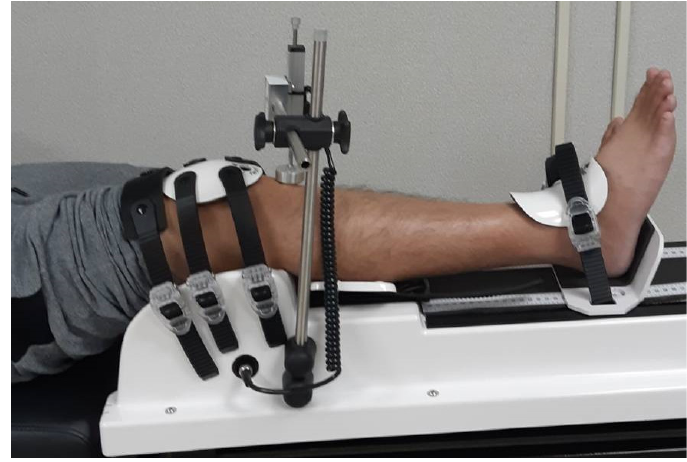
Figure 1. GNRB (Genourob, Laval, France) arthrometer used in our institute.